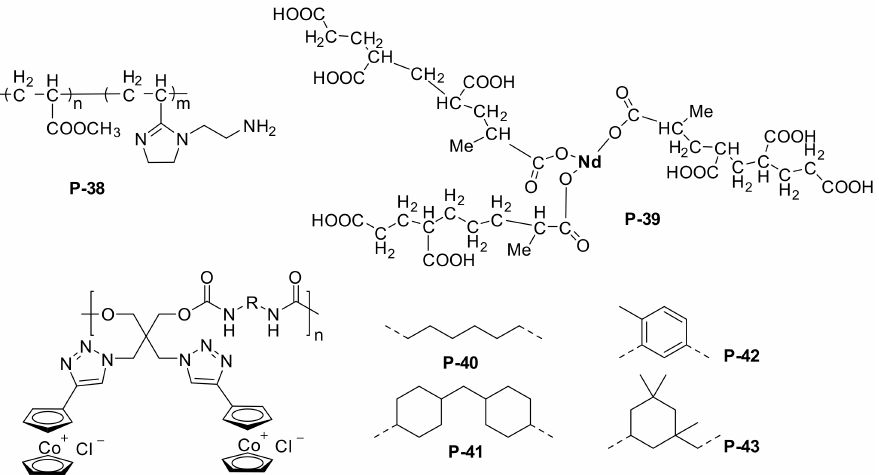
Figure 13. Chemical structure of the poly methyl acrylate-acrylic acid imidazoline, and cobaltocenium- containing waterborne polymeric inhibitors.